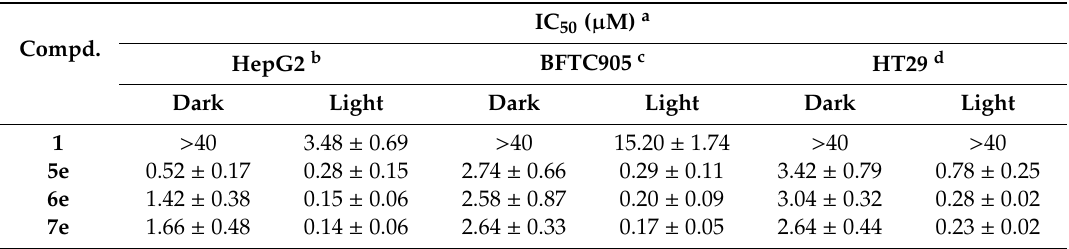
a Compound concentration ( µ M) required to inhibit tumor cell proliferation rate by 50%. Data are expressed as the mean ± SD from the dose-response curves of at 3–5 independent experiments. b Human hepatocarcinoma cell lines. c Human bladder cancer cell lines. d Human colon adenocarcinoma cell